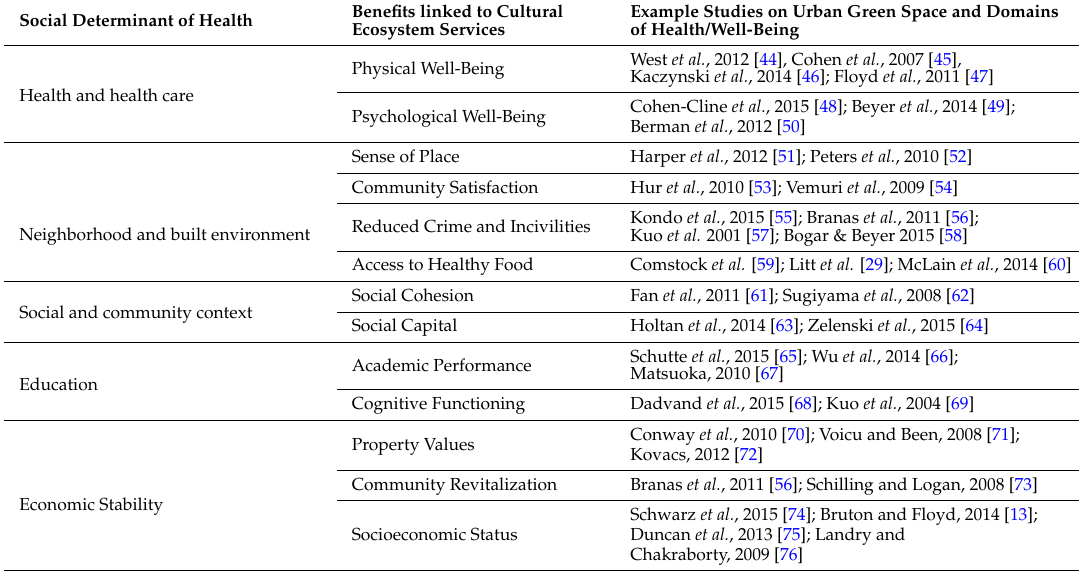
Table 1. Connections between social determinants of health and benefits linked to cultural ecosystem services provided by urban green